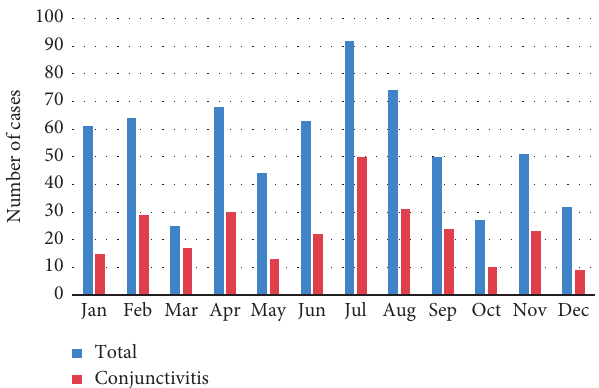
Figure 5: Conjunctivitis distribution throughout the year.